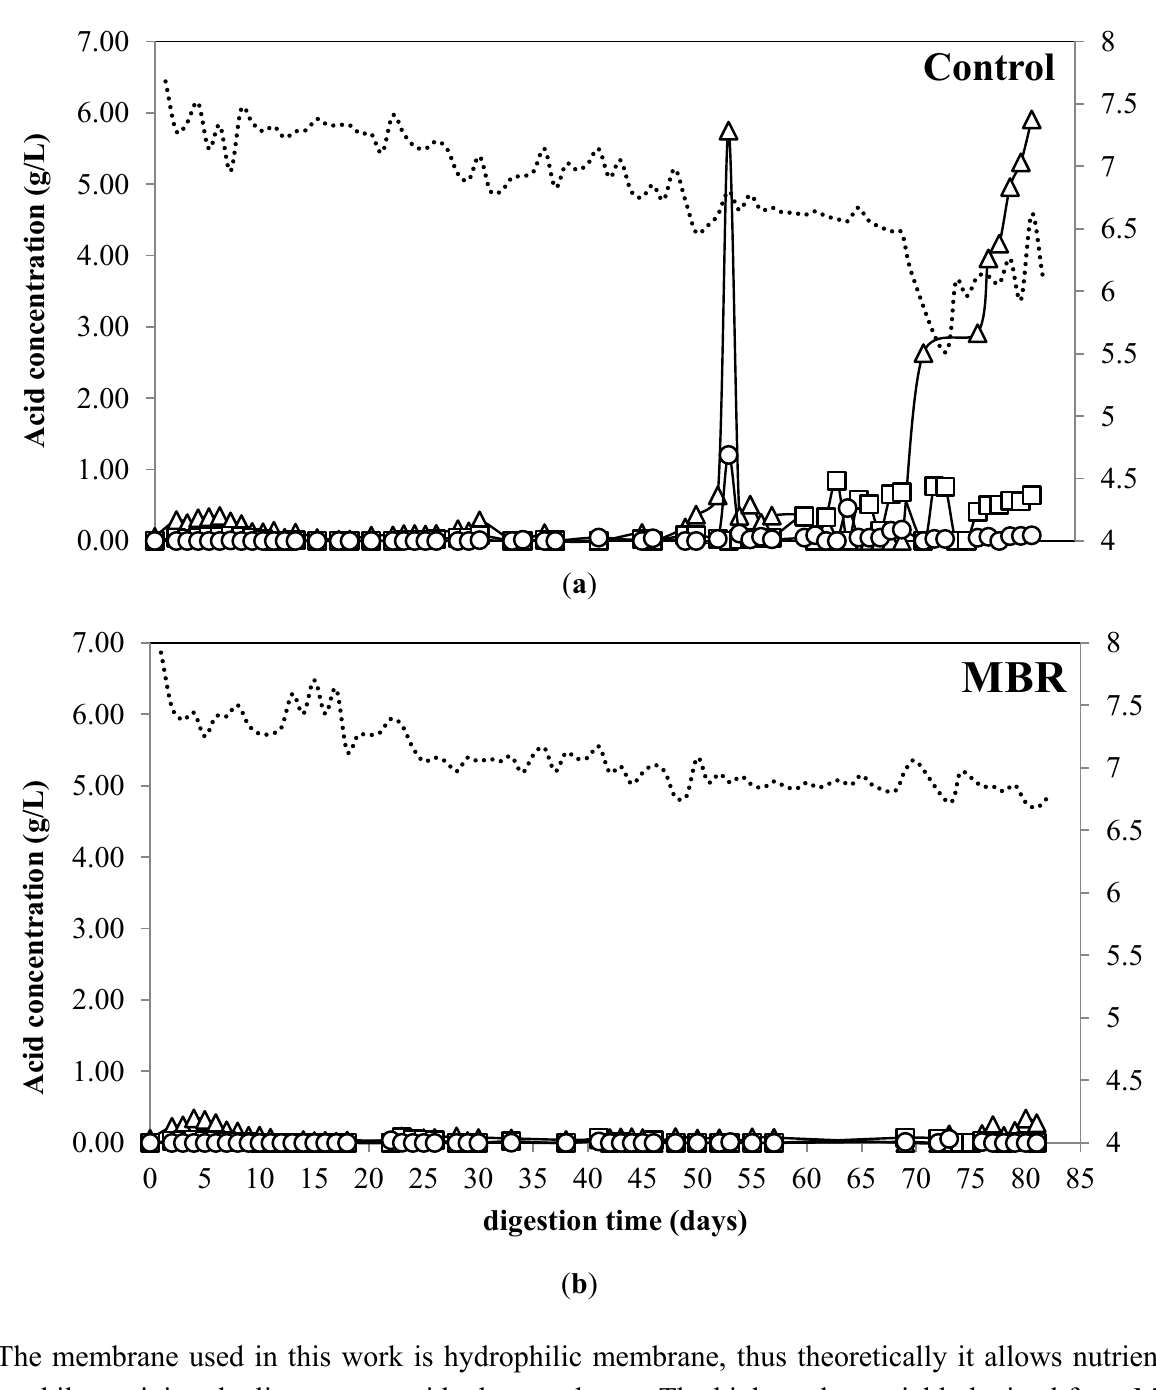
Figure 4. Acetic acid ( ∆ ), propionic acid ( □ ), isobutyric acid ( ○ ), and pH ( --- ) of anaerobic digestion from citrus waste using ( a ) MBR and ( b )